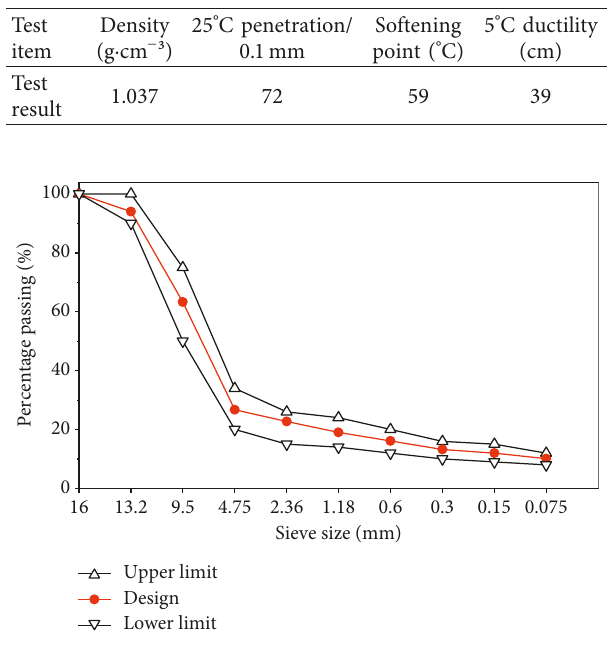
Table 2: Basic properties of SBS modified asphalt.